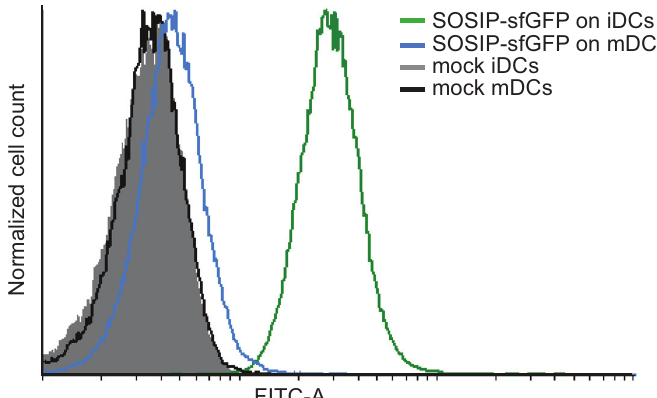
Figure 5. Use of SOSIP-sfGFP in a fluorescence-based assay. FACS histogram plots (FITC channel) of iDCs and mDCs stained with 20 (cid:2)g/mL SOSIP-sfGFP. No SOSIP-sfGFP to the cells was added as negative control